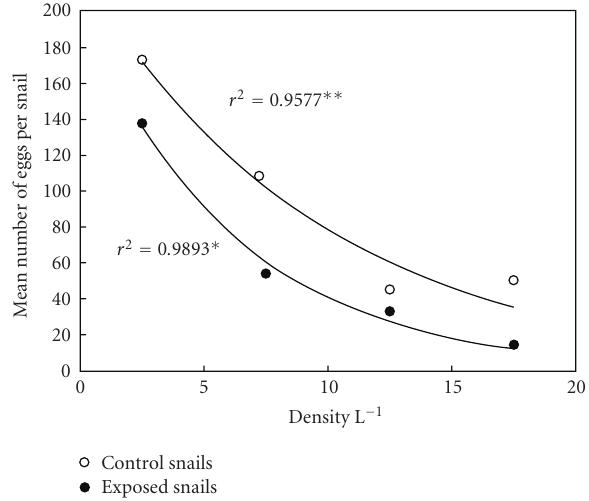
Figure 3: Regression analyses of the mean number of eggs produced by each snail over the 10-week study period. Values were averaged for all snails in each treatment group. Regression analysis was performed using an exponential decay model. ∗ Exposed treatment, mean number of eggs per snail = 208.7 × exp( − 0.0797 × Density). ∗∗ Unexposed treatment, mean number of eggs per snail = 231.03 × exp( − 0.0524 ×